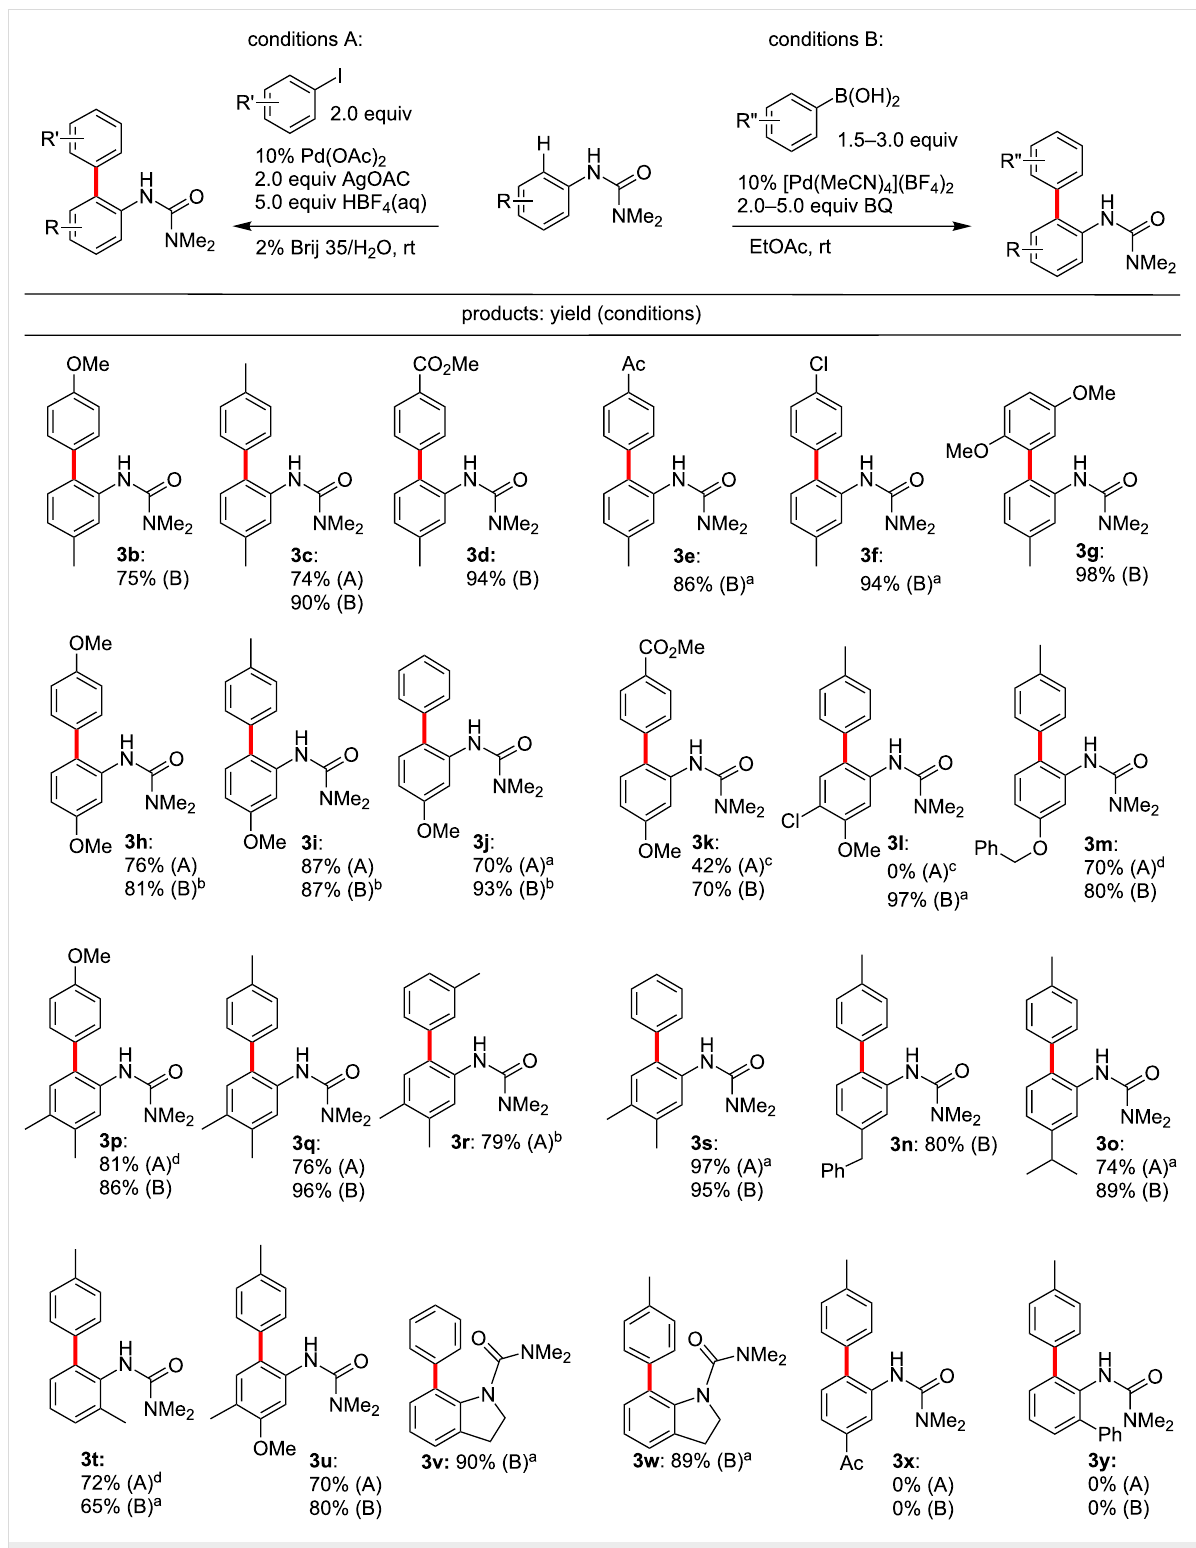
Figure 2: C–H arylation results. Conditions A: Conducted at rt for 20 h in 2 wt % Brij 35/water (1 mL) with 10 mol % Pd(OAc) 2 , AgOAc (2 equiv), HBF 4 (5 equiv), arylurea ( 1 , 0.25 mmol), and ArI (2.0 equiv). Conditions B: Conducted at rt for 20 h in EtOAc (1 mL) with 10 mol % [Pd(MeCN) 4 ](BF 4 ) 2 , BQ (2 or 5 equiv), arylurea ( 1 , 0.25 mmol), and ArB(OH) 2 (1.5 or 3 equiv). a Run for 48 h. b 2 equiv of BQ. c Run for 96 h. d Run for 72